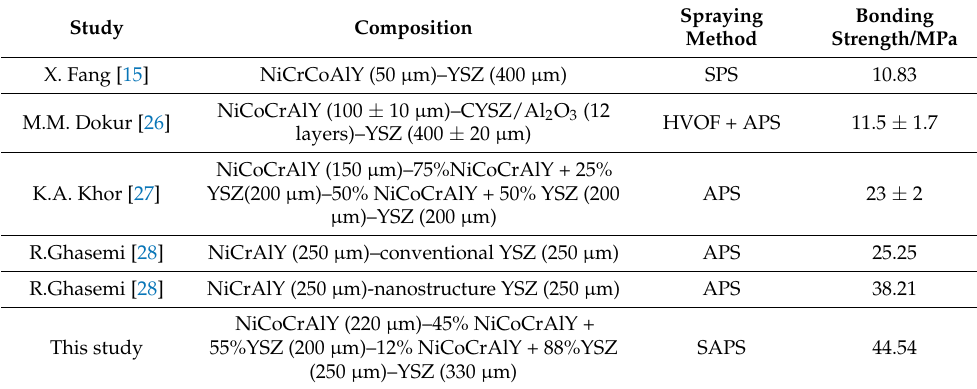
Table 3. Bonding strengths of TBCs from different studies.